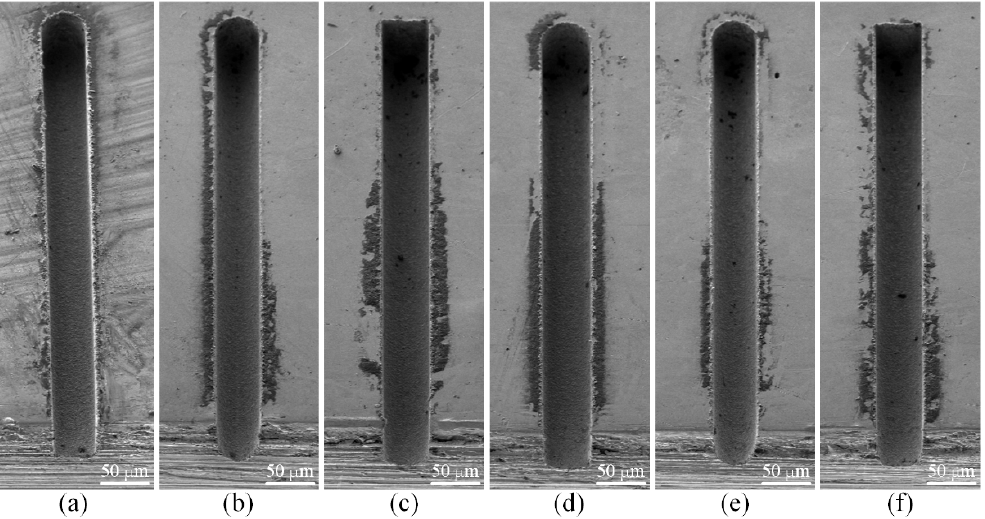
Figure 15. SEM images of the six microgrooves in Exp. 1: ( a ) cylindrical electrode-rotating mode-unidirectional path; ( b ) cylindrical electrode-nonrotating mode-unidirectional path; ( c ) square electrode-nonrotating mode-unidirectional path; ( d ) cylindrical electrode-rotating mode-reciprocating path; ( e ) cylindrical electrode-nonrotating mode-reciprocating path; ( f ) square electrode-nonrotating mode-reciprocating path.